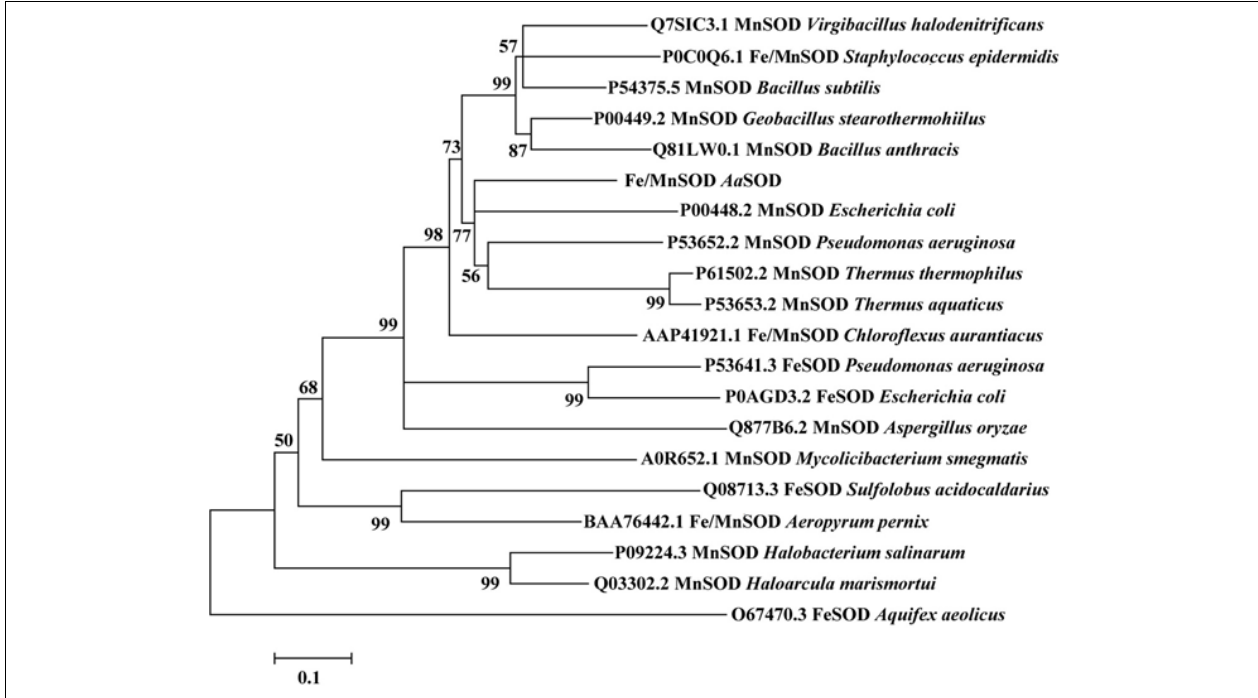
FIGURE 1 | Neighbor-joining phylogenetic tree based on the amino sequences of Aa SOD and its closest relatives retrieved from NCBI database. The tree was built by the program MEGA version 7.0. Bootstrap percentages > 50% (based on 1000 replications) are shown at branch points.